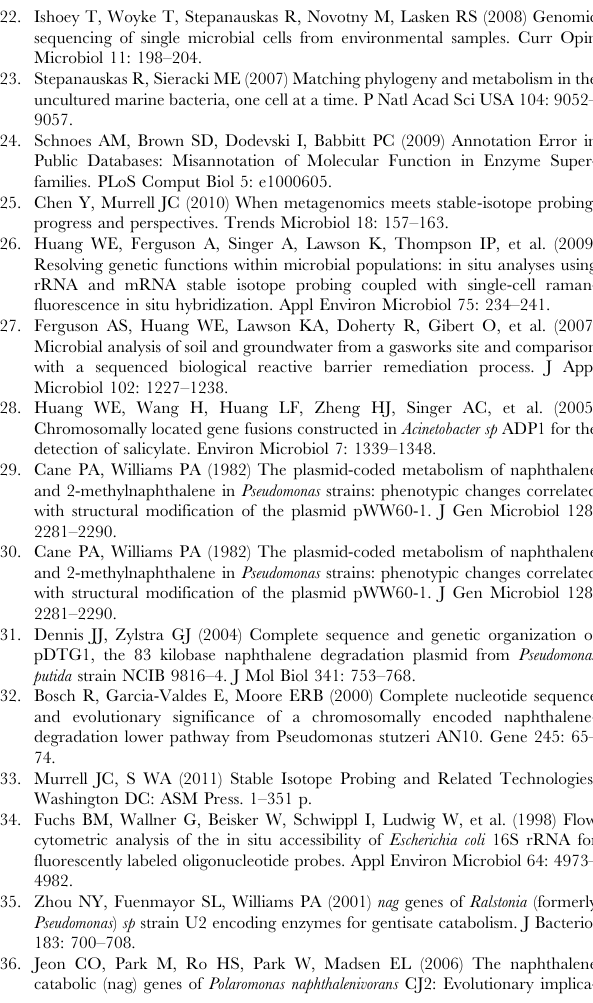
numbers on the bottom right are the codes of individual 454 sequence reads. (PDF) Figure S7 A single pyrosequencing read in the 13 C-DNA fraction links nag B and nag F in nag2 operon. (PDF) Table S1 Homology analysis of nag2 and nag-CJ2/nag-U2.